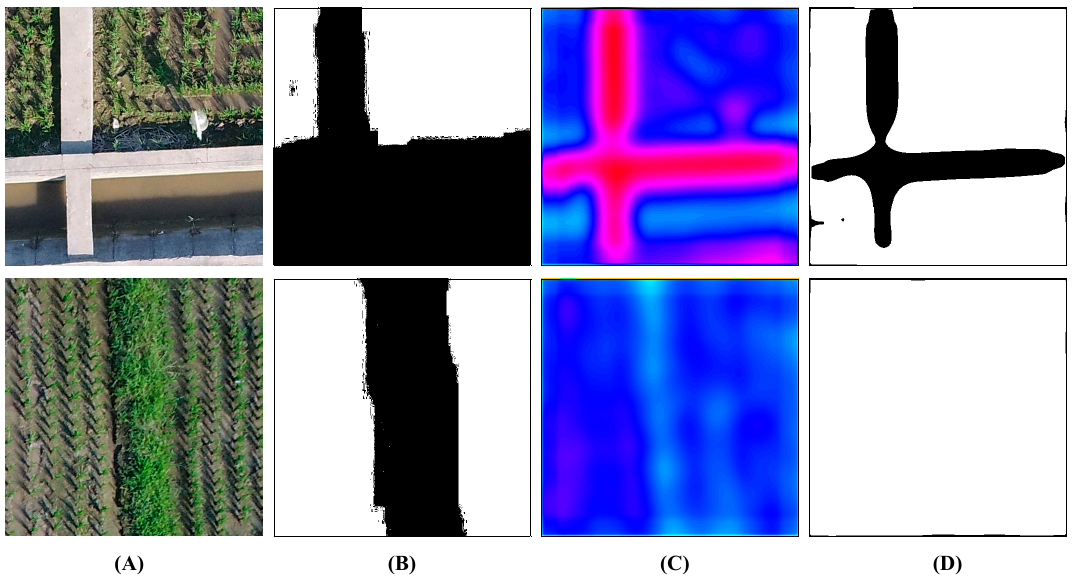
Figure 13. Two examples of erroneous predictions obtained from the Segmentation Network: ( A ) cropped UAV images, where the upper image contains roads, shadows, and rice seedling areas, while the lower image contains weeds and rice seedling areas; ( B ) the corresponding ground truth binary maps; ( C ) segmentation maps predicted by the Segmentation Network; ( D ) the corresponding binary maps generated by Equation (1) based on the empirically determined intensity value threshold range.